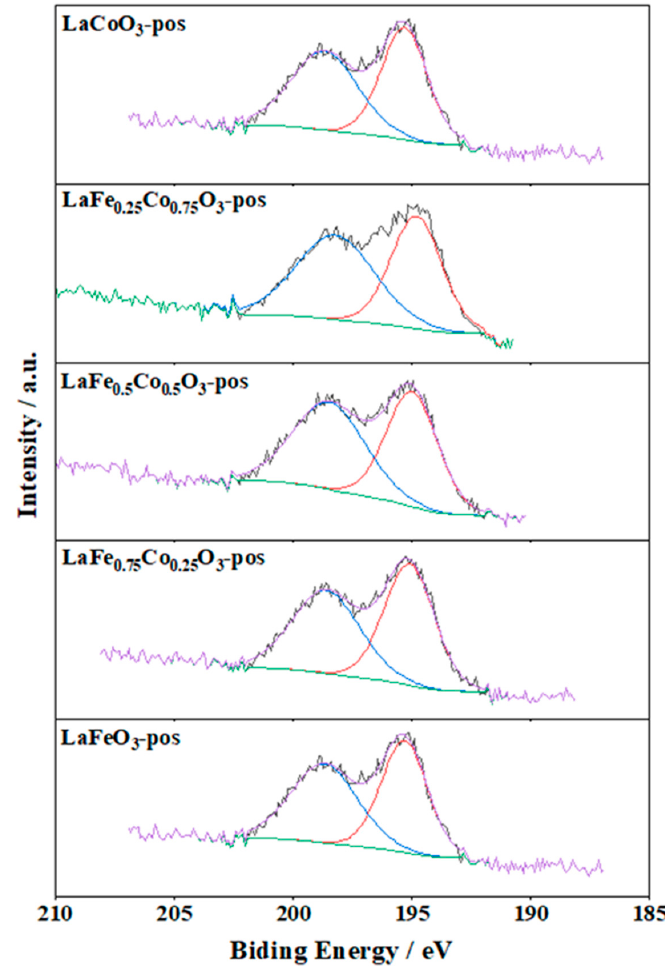
Figure 11. Cl2p XPS spectra of pos-reaction catalysts.